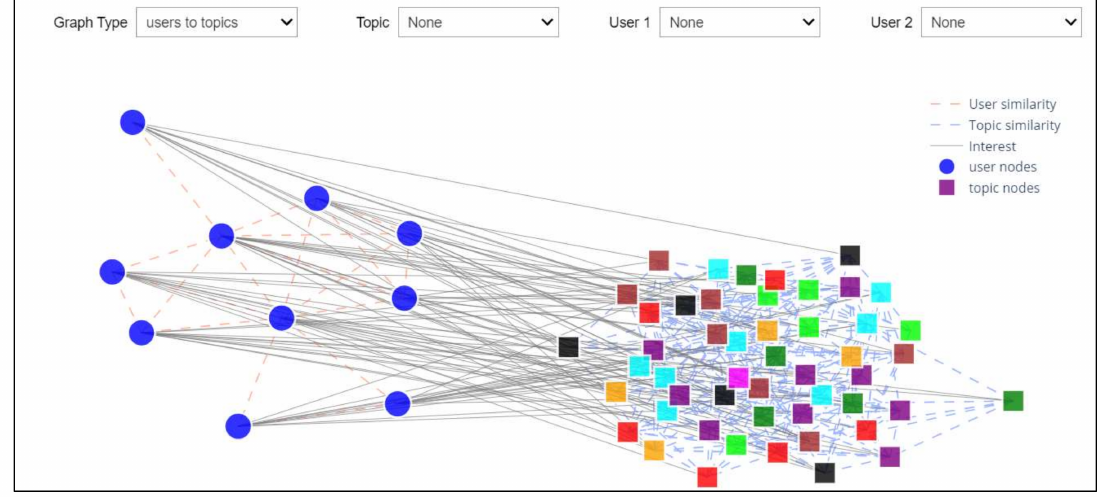
Figure 12. Graph with